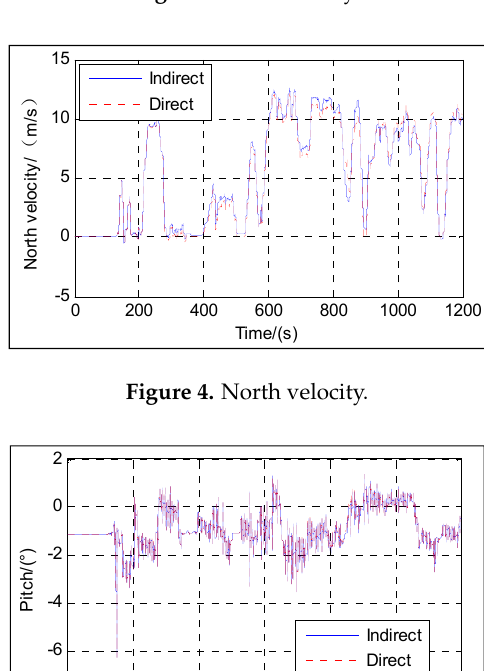
Figure 3. East velocity.